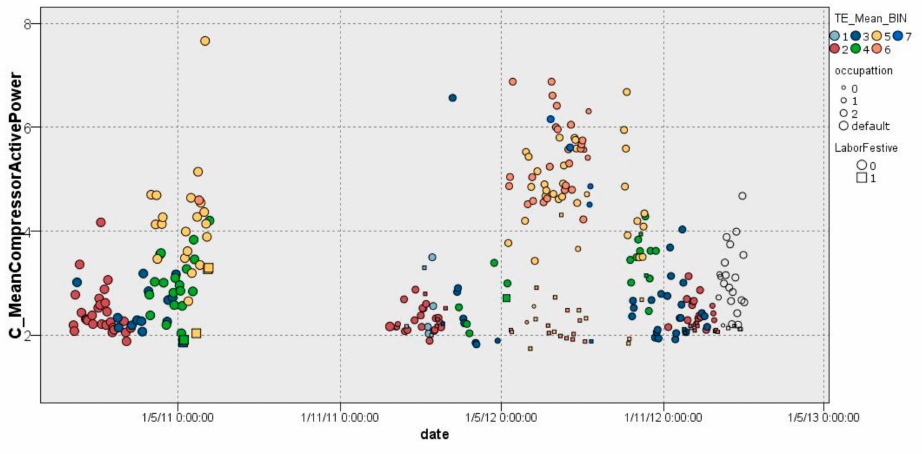
Figure 3. Sample compressor consumption